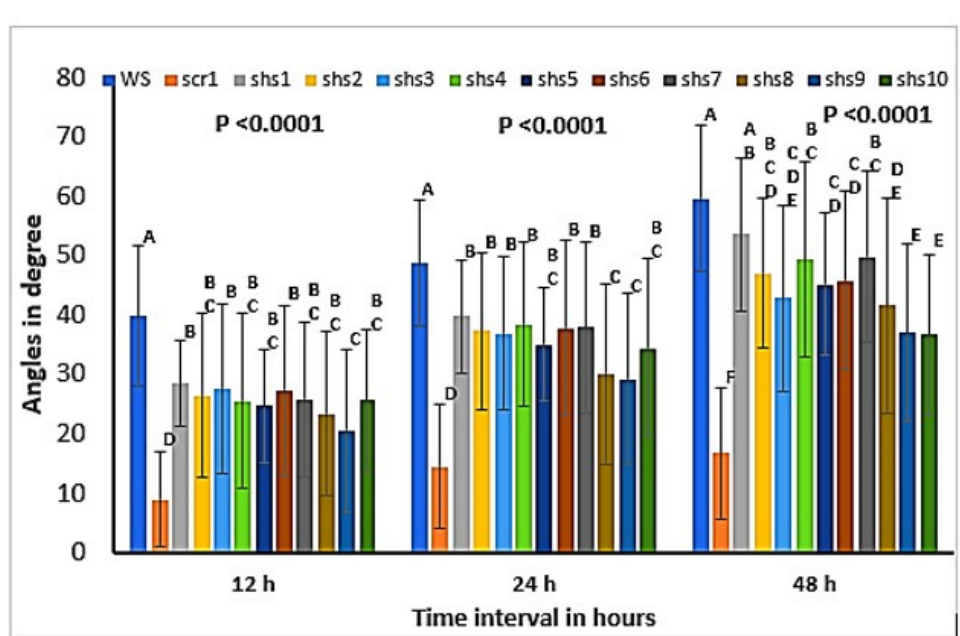
Figure 2. Hypocotyl gravitropic responses of A. thaliana wild type (WS), scr1 and 10 confirmed scr hypocotyl gravitropic suppressors ( shs1–10 ). Gravitropic responses to new gravity vectors of all the samples were measured in degrees at three time points. The X-axis represents the time interval in hours and the Y-axis represents the angle of deflection of hypocotyls. All 10 scr hypocotyl gravitropic suppressors ( shs1–10 ) have gravitropic responses above the level of scr1 but below WS. Error bars represent the means ± standard deviation (SD). The lack of shared letters on the bars indicates a significant difference. To determine the significant differences between wild type and mutant seedlings, we used ANOVA followed by Fisher’s test.